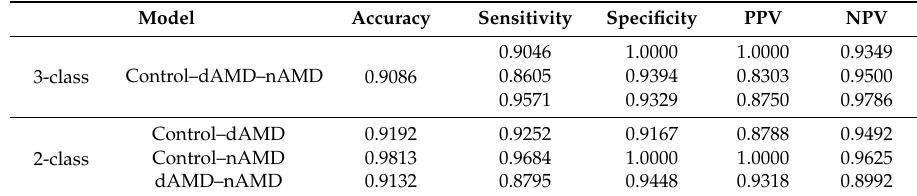
Table 4. Average classification results for each model.